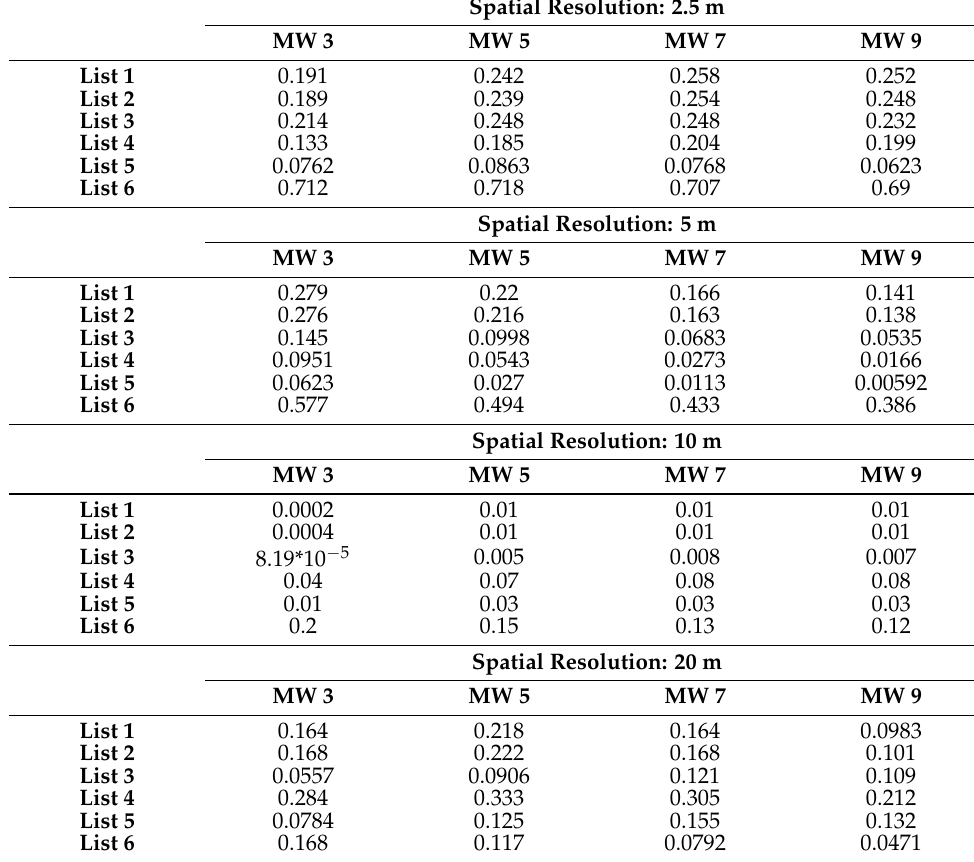
Table 5. R 2 referred to linear models between the means of the matrices of the “multidimension” method of Rao’s Q index (at different spatial resolutions and MWs) and the Shannon’s H. Spatial Resolution: 2.5